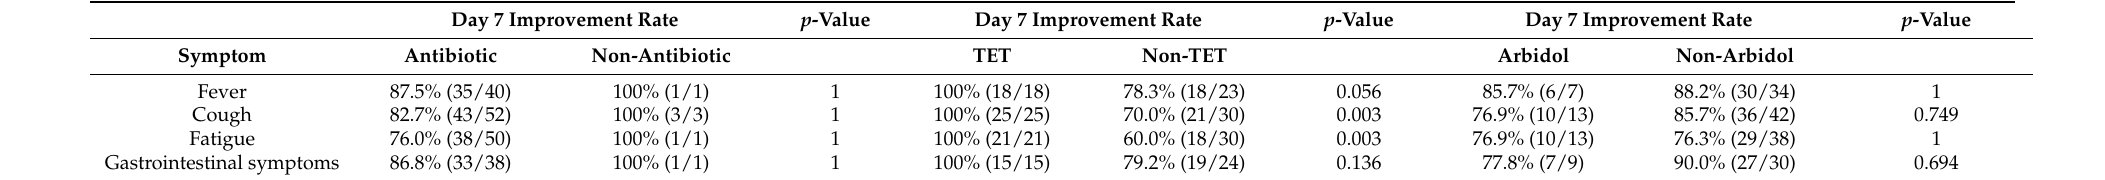
Table 4. Improvement of clinical symptoms in total COVID-19 patients with and without antibiotic, tetrandrine, and arbidol.